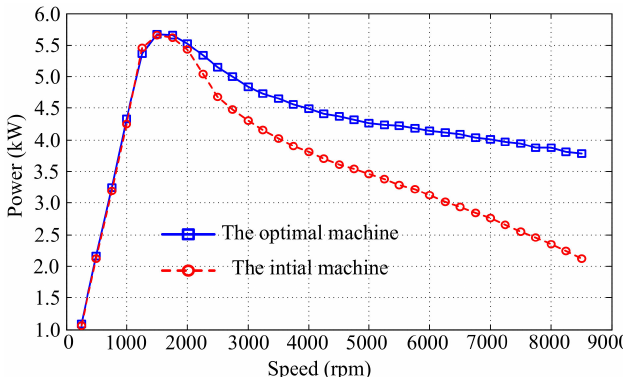
Figure 12. The power-speed characteristics of the initial machine and optimal machine.